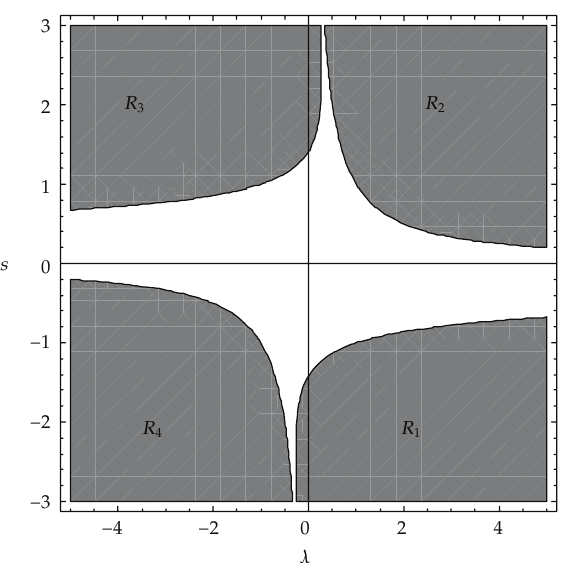
Figure 5: Existence four domains of (cid:3) 5.14 (cid:4) and (cid:3) 5.15 (cid:4) in the parameter plane (cid:3) λ,s (cid:4) at m (cid:8) − 1 and σ (cid:8)